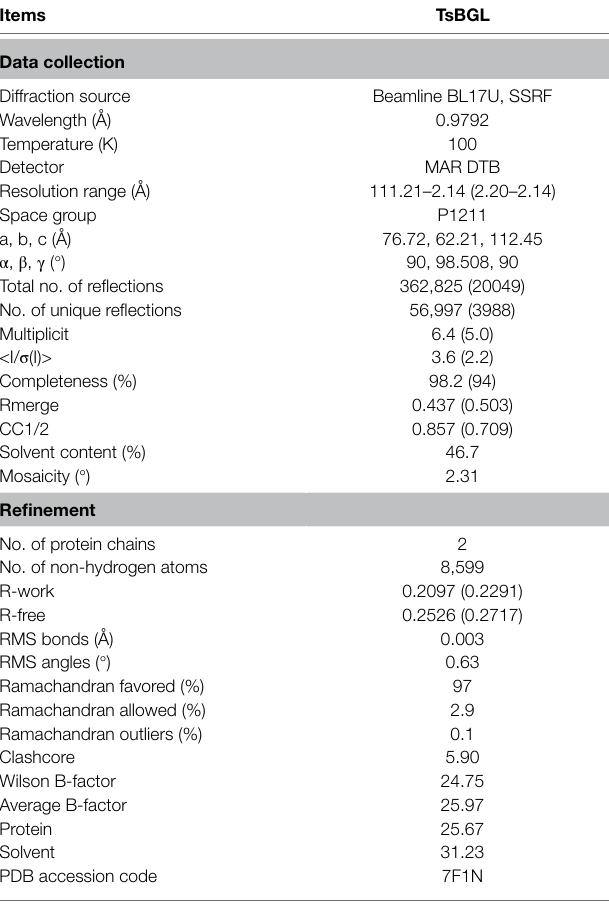
TABLE 3 | Data collection and structure refinement